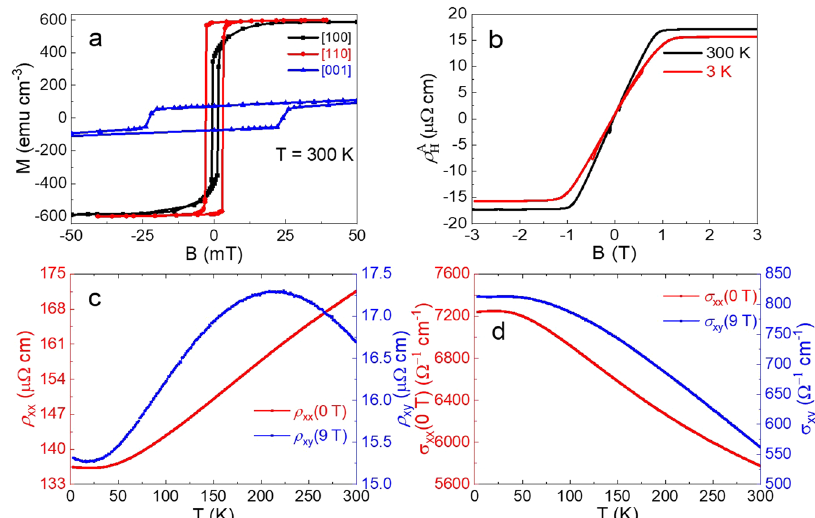
Fig. 2 Magnetic and electric transport measurements for 50 nm Co 2 MnGa. a Magnetization measured at 300 K with the magnetic fi eld along in-plane and out-of-plane direction, respectively. b Anomalous Hall effect measurements at 3 and 300 K, respectively. c Longitudinal resistivity without fi eld (red) and Hall resistivity cooling down with 9 T (blue) as a function of temperature from 3 to 300 K. d the corresponding conductivity as a function of temperature from 3 to 300